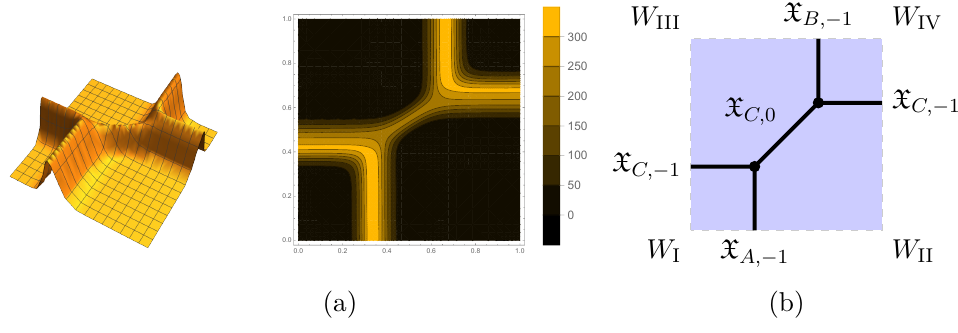
Figure 10 . (a) Density ρ ( t, s ) for numerically simulated soliton scattering process in the model W ( Y ) = 1 . 0 × Y − 0 . 01 × e Y − e − Y ; and (b) diagrammatic depiction of the soliton scattering